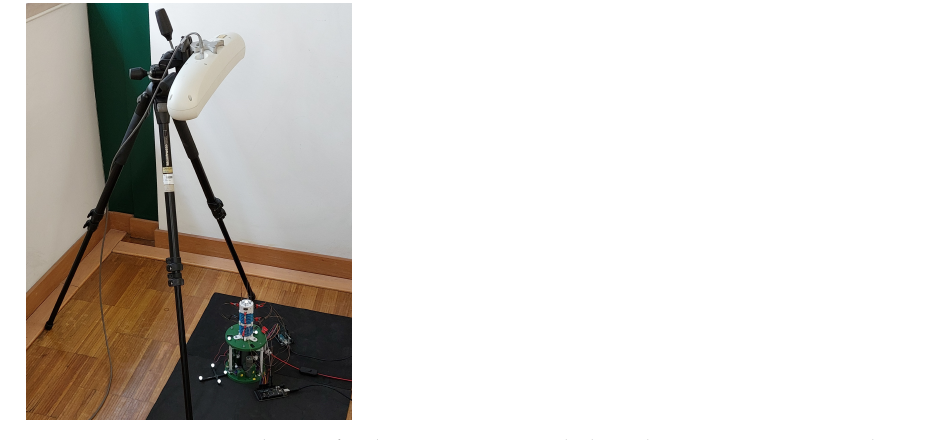
Figure 15. Experimental setup for data acquisition with the Polaris Spectra™ 3D Tracking